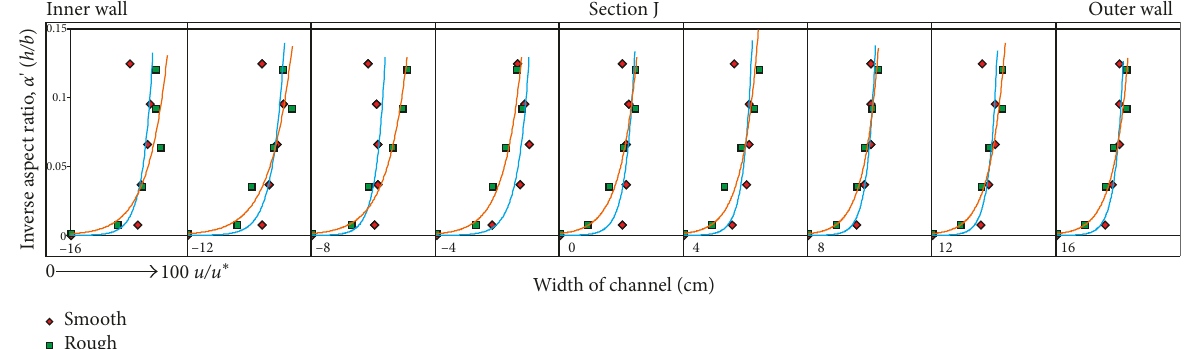
Figure 13: Comparison of velocity variation in section J.